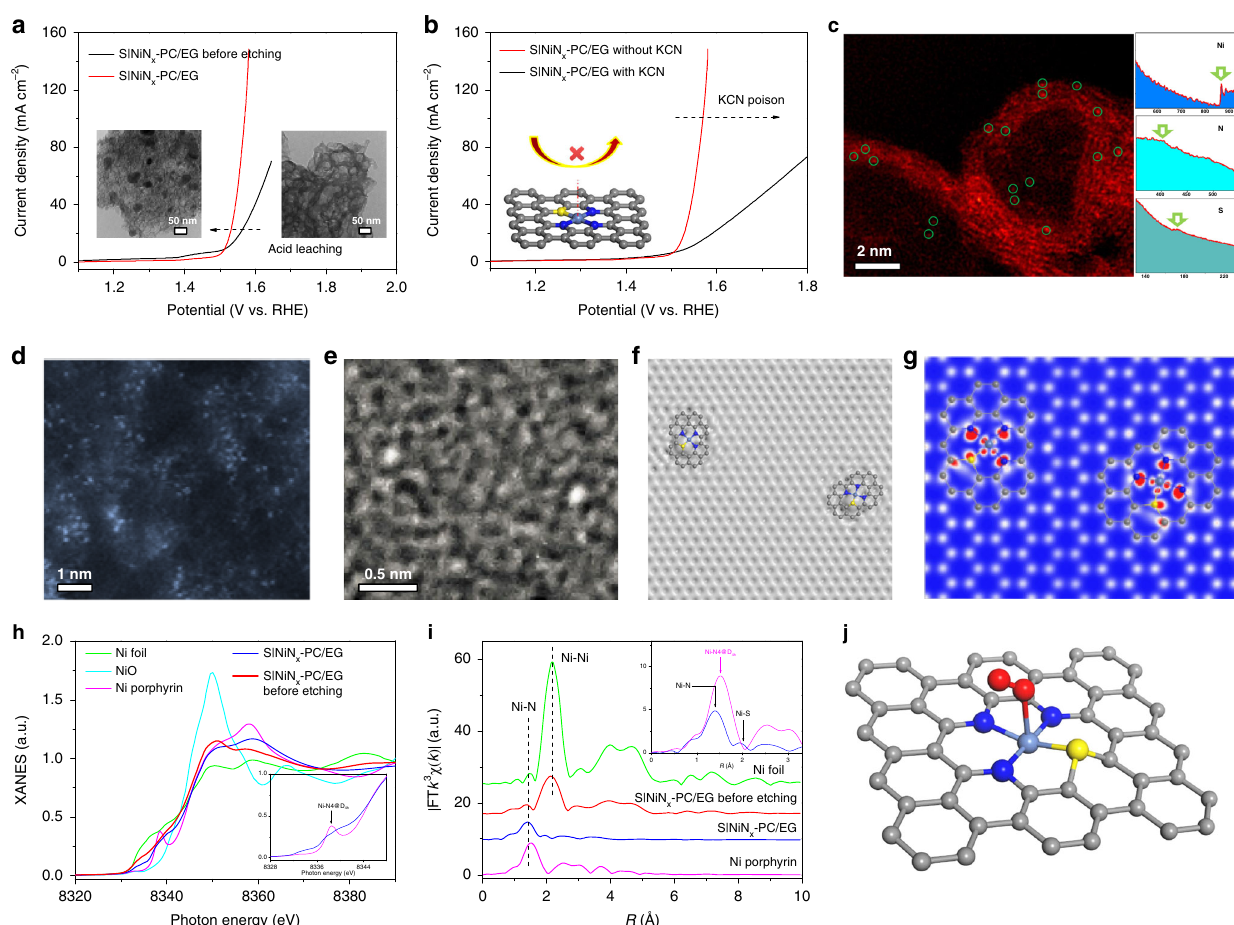
Fig. 3 Understanding the structure of active sites. a Comparison of the OER activity of S|NiN x − PC/EG and S|NiN x − PC/EG before etching. Insets are TEM images showing that the Ni nanoparticles were removed by acid etching treatment. b Polarization curves of S|NiN x − PC/EG with and without 10 mM KCN, indicating that CN − ions strongly poison the S|NiN x − PC/EG. Insets: illustrations of S|NiN x centers blocked by the CN − ions. c HAADF-STEM image of S|NiN x − PC/EG and corresponding electron energy loss spectroscopy atomic spectra of Ni, N, and S elements from the bright dots, as shown by the green circle arrow in c . d , e Atomic-resolution HAADF-STEM images of S|NiN x − PC/EG. f , g Simulated HRTEM and STM images for e . h Ni K-edge XANES spectrum and i Ni K-edge k3-weighted EXAFS spectrum of S|NiN x − PC/EG; data for the Ni foil, NiO, Ni porphyrin, and S|NiN x − PC/EG before etching are also shown. The insets are the magni fi ed images. j Schematic structural model for S|NiN x − PC. The steel blue, blue, yellow, gray, and red spheres represent Ni, N, S, C, and O atoms,